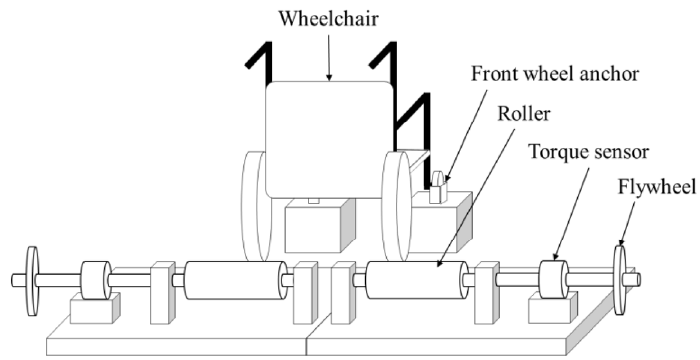
Figure 1. A wheelchair dynamometer developed for this